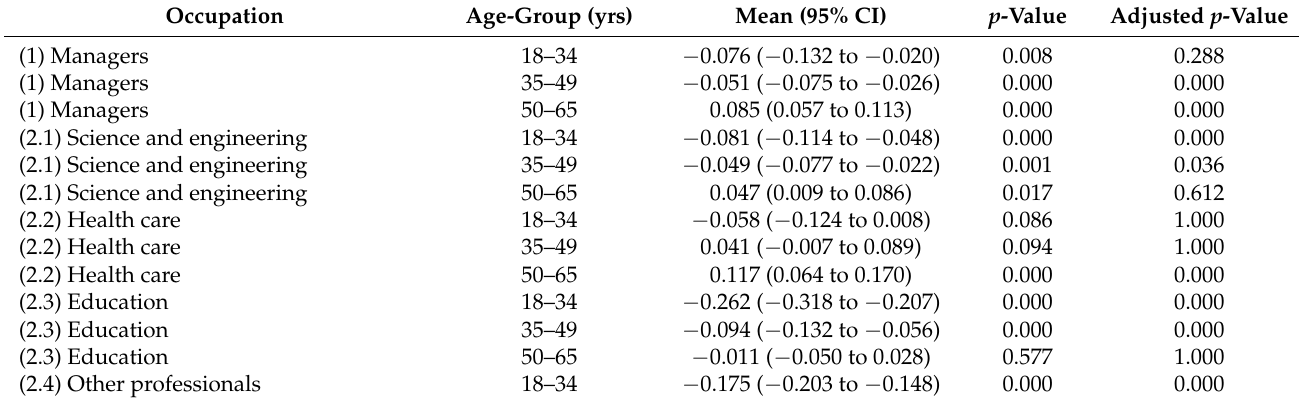
Table A3. Interaction effect linear regression model according to